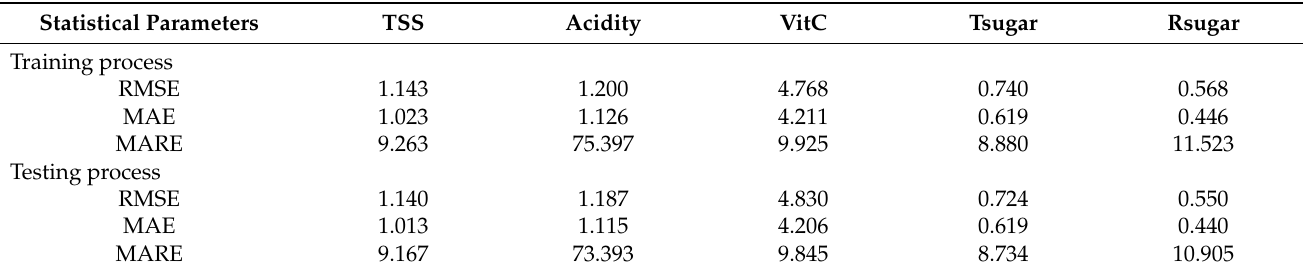
Table 9. Statistical performance of the developed MLR models for total soluble solids (TSS), acid- ity, vitamin C (VitC), total sugars (Tsugar), and reducing sugars (Rsugar) for the training and testing